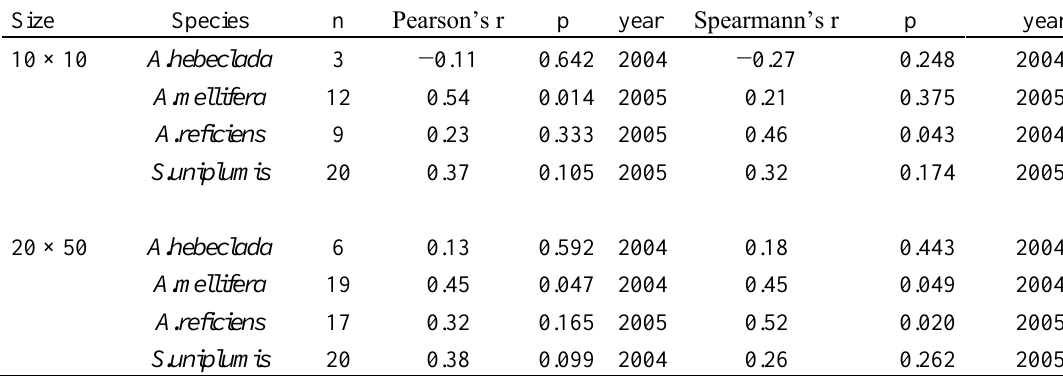
Table 3. External validation of the species cover maps for two plot sizes. The number of plots where a species occurs (n) is given per plot size. Parametric (Pearson) and non-parametric (Spearman) correlation values are shown. The p-value is based on a two-tailed probability test for correlating values. The column ‗year‗ marks the year with the highest correlation values